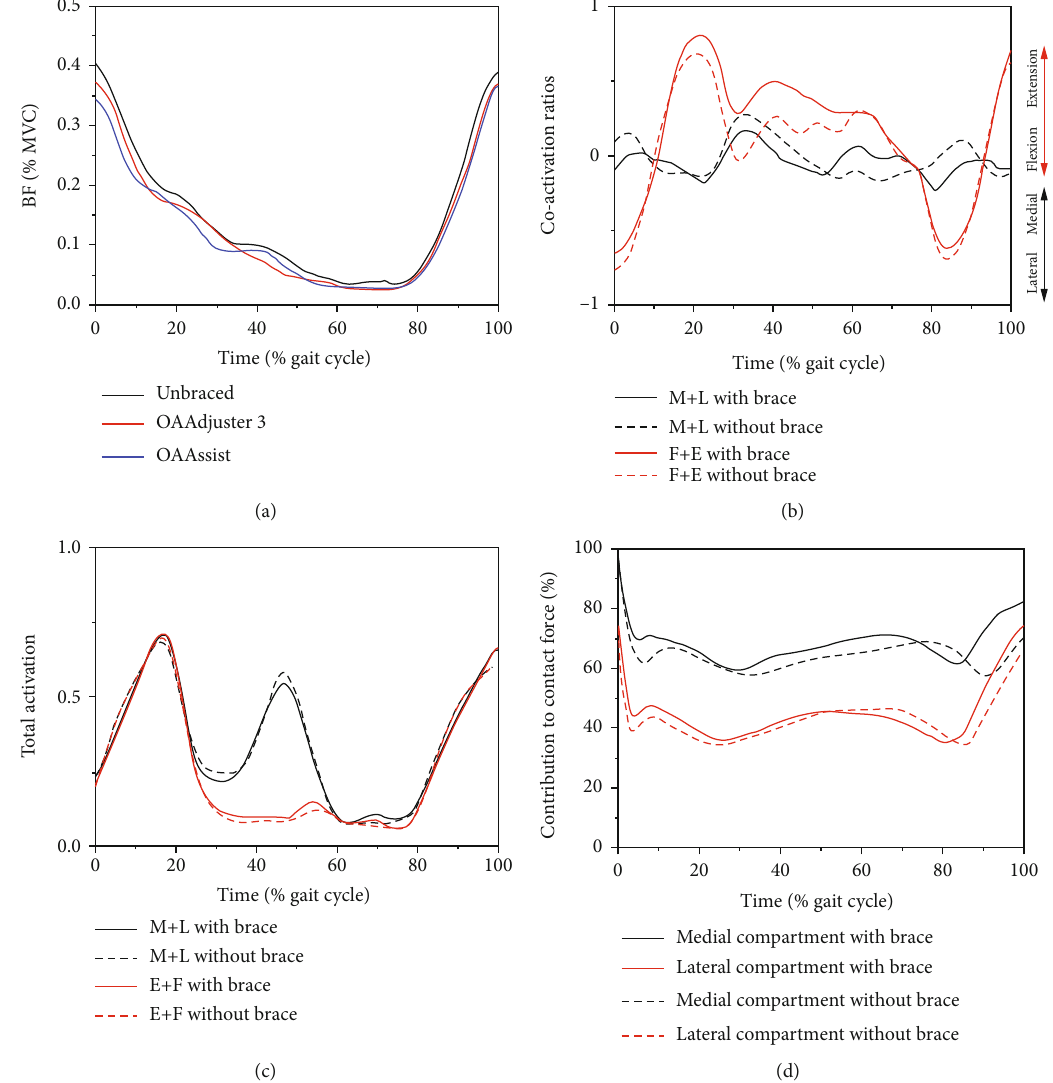
Figure 7: Changes in knee joint muscle parameters. (a) Mean enveloped electromyography (EMG) of biceps femoris (BF) in unbraced, OA Adjuster 3, and OA Assist braced condition [22]. (b) Cocontraction ratios (CCRs) with/without brace [21]. (c) Muscle activation with/ without brace [21]. (d) Relative contributions of muscle to medial and lateral compartment tibiofemoral contact force with/without brace [21]. M+L: medial and lateral directed; F+E: fl exion and extension